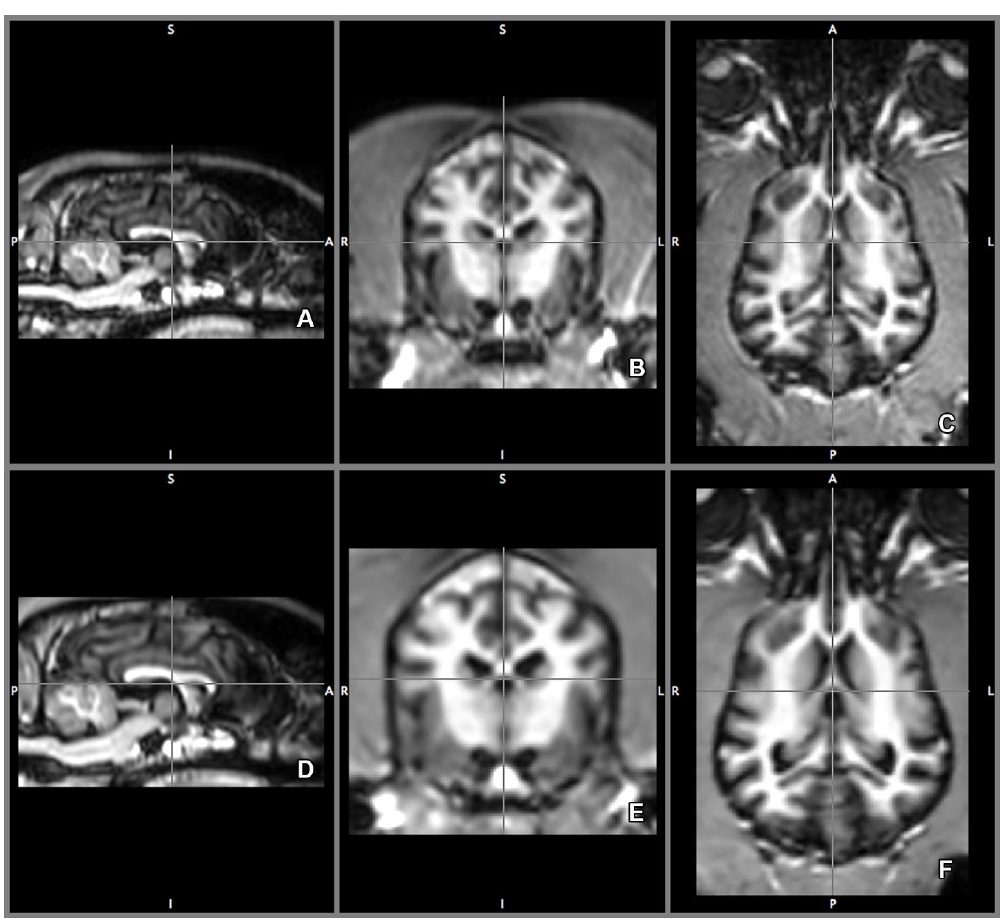
Figure 5. Ventricular changes over time of the same dog, at the 1st scan ( A – C ) and 4 years later at the 2nd scan ( D – F ). Directions are referred as superior (S), inferior (I), posterior (P), anterior (A), left (L) and right (R). Vet. Sci. 2020 , 7 , x FOR PEER REVIEW